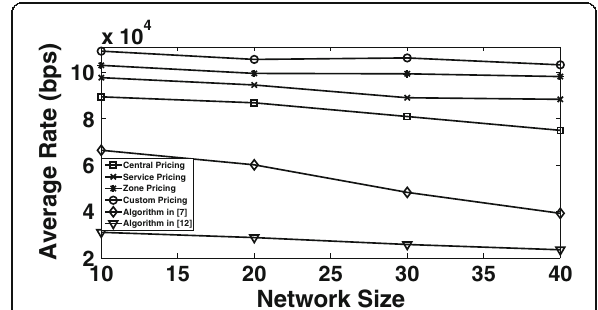
Fig. 1 Users ’ average uplink transmission data rate versus